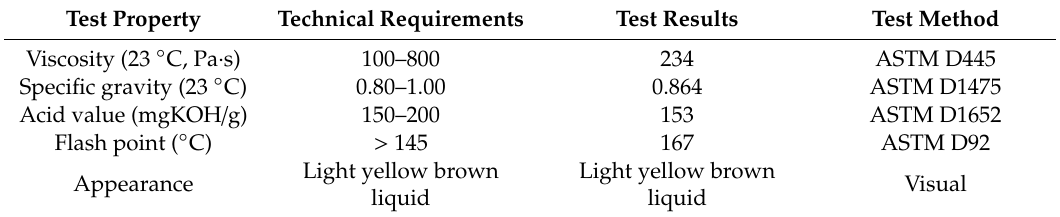
Table 3. Performance and technical requirements of the curing agent for epoxy